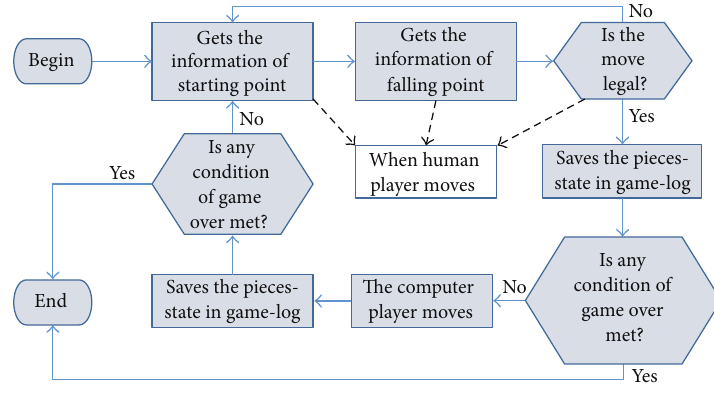
Figure 15: Gameplay of the human-human mode.